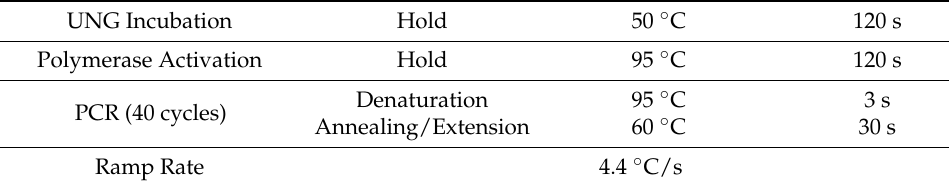
Table 6. qRT-PCR setup.